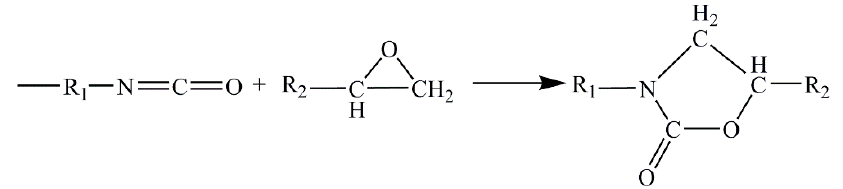
Figure 9. The reaction between –NCO and epoxy groups.